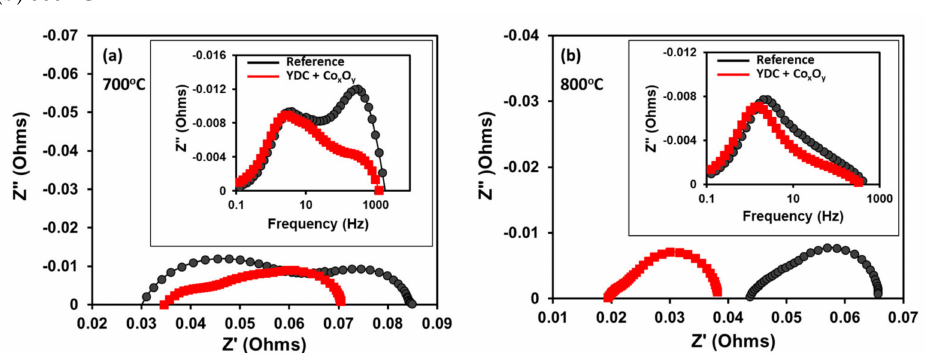
Figure 5. EIS Nyquist plots of infiltrated and reference cells recorded at ( a ) 700 ◦ C and ( b ) 800 ◦ C (the insets in the figures represent the Bode plots at relevant